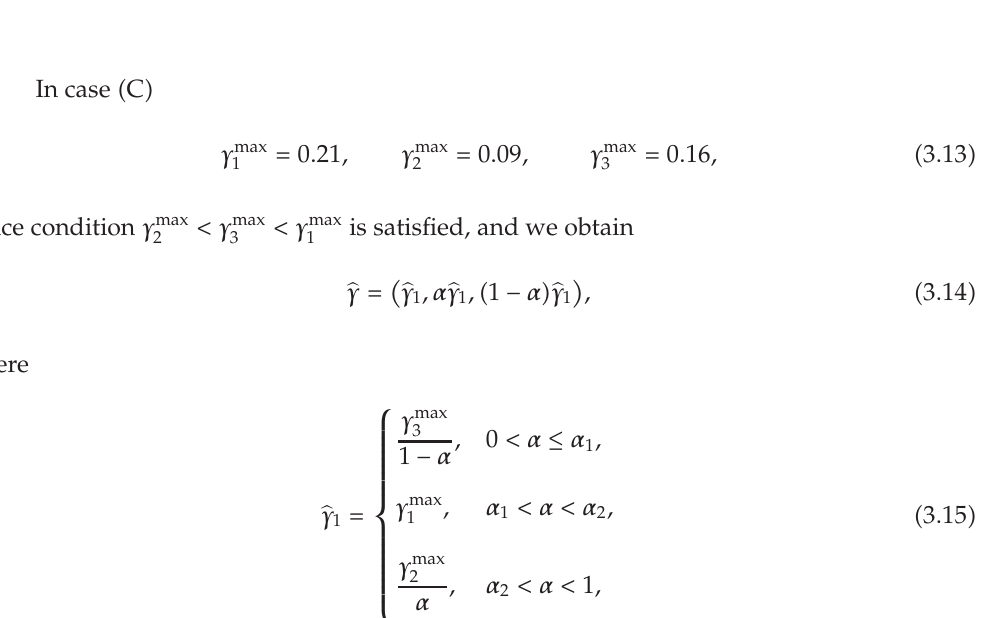
Figure 4: Case (cid:4) C (cid:7) : behaviour of W 1 and W 2 for T su ffi ciently